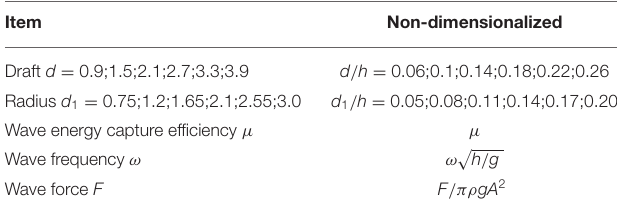
TABLE 2 | Non-dimensionalized